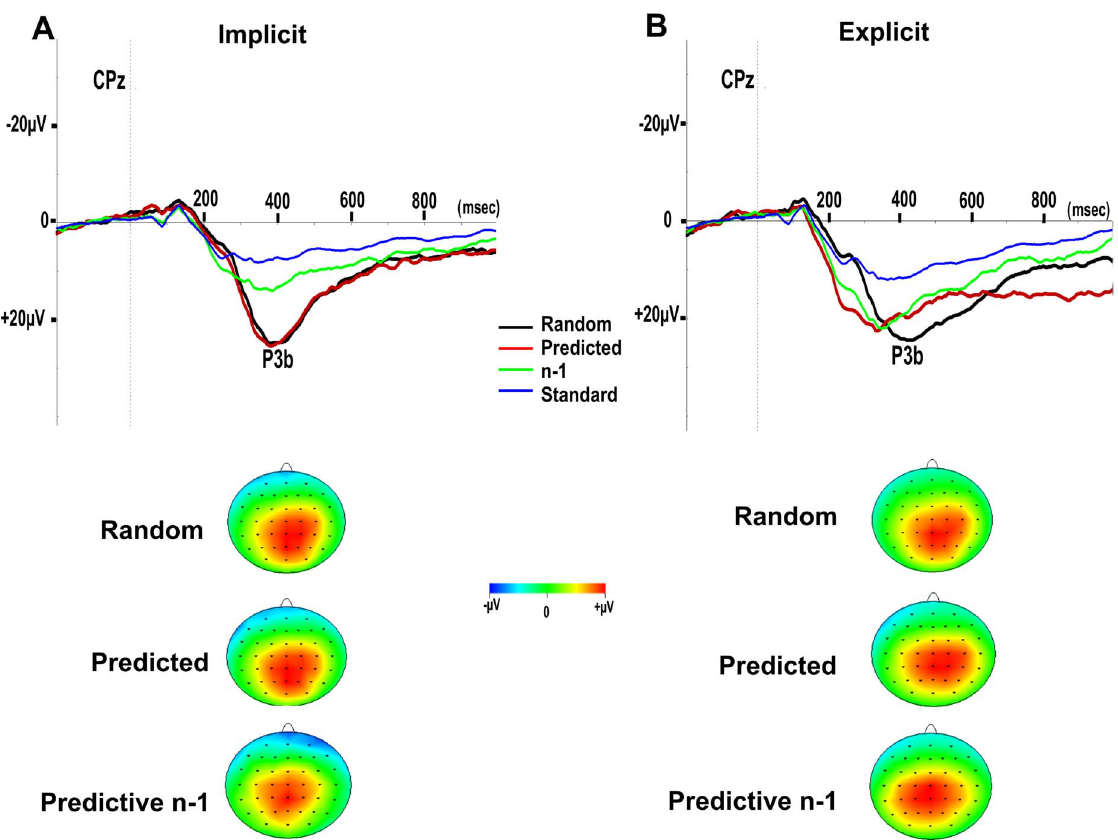
Figure 3. Grand average at CPz for the 4 conditions: targets after random non predictive (Random) and predictive sequences (Predicted), the last most informative standard comprising the predicting sequence (n-1) and random preceding standards (Standard); and the topographic maps of predicted, random targets and n-1, for implicit (A) and explicit (B) sessions. Vertical dotted lines indicate time of stimulus presentation onset.